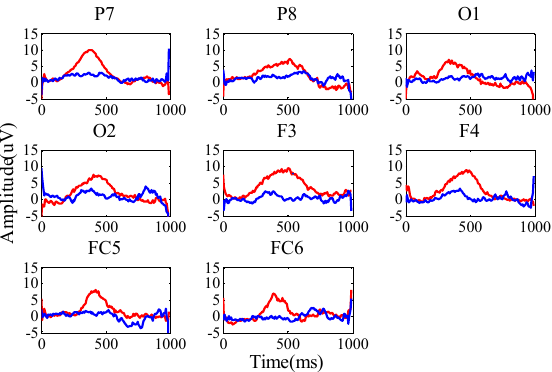
Figure 6. EEG-related potentials with target and non-target stimulation.